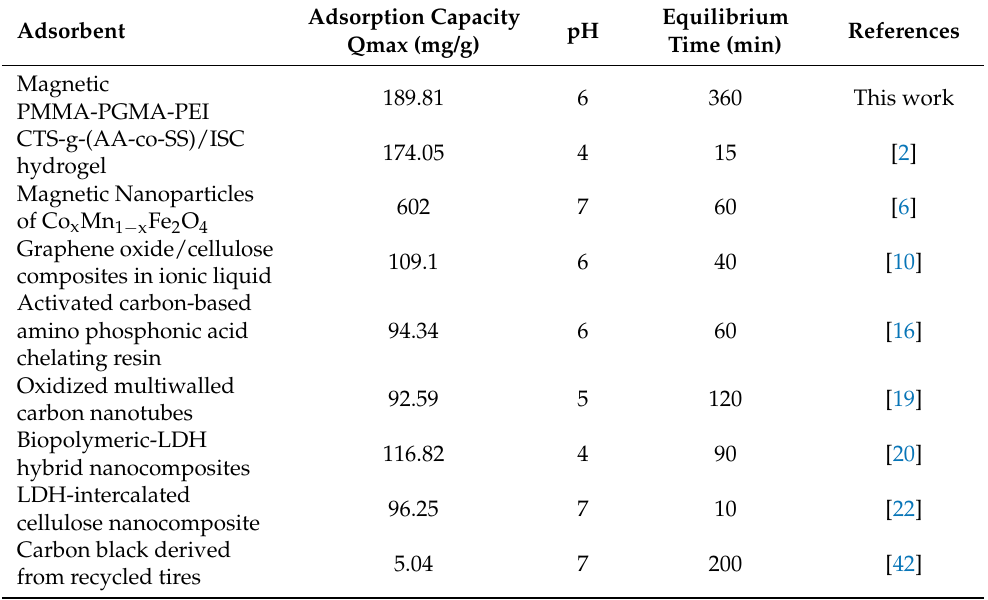
Table 4. Comparison of the Ce(III) Removal Performance with Other